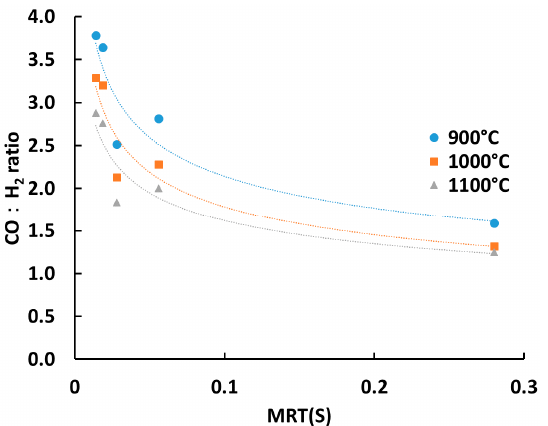
Figure 9. Effect of MRT and temperature on CO:H 2 ratio for a feed ratio of 1:1 CO 2 :CH 4 .